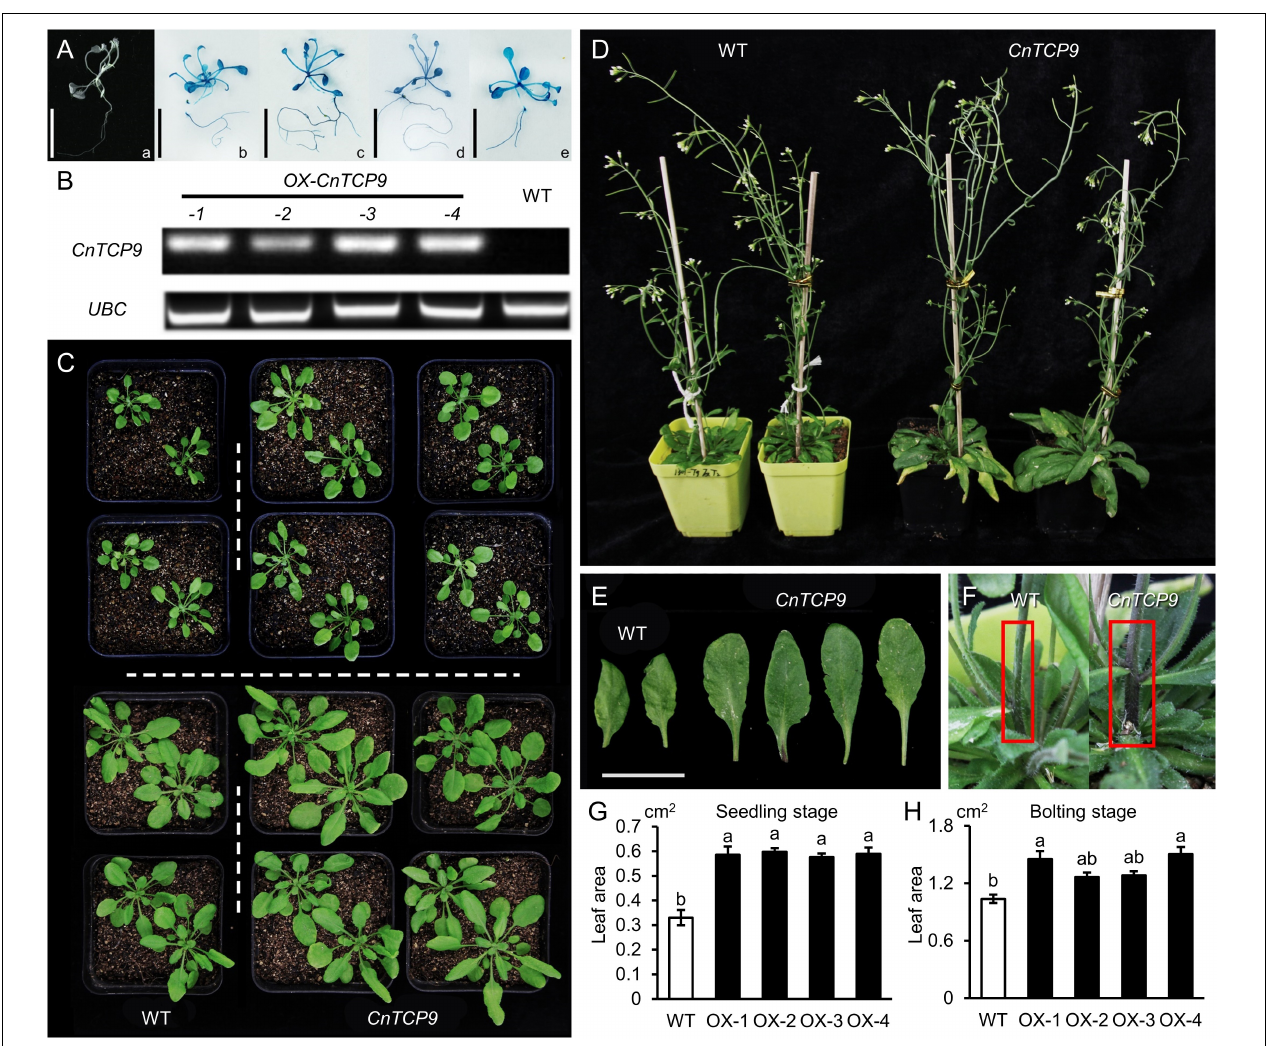
FIGURE 5 | Phenotype of overexpressing CnTCP9 in Arabidopsis. (A) GUS staining of T 3 generation. (a) Non-transgenic Arabidopsis was used as the negative control. (b–e) Transgenic CnTCP9 positive seedlings. (B) RT-PCR of CnTCP9 in WT and OE (Overexpressing CnTCP9 Arabidopsis). (C) Germination period and seedling period of WT and OE. (D) Mature period of WT and OE. (E) Leaves of WT and OE; bar = 2 cm. (F) The main stem of WT and OE. (G,H) Statistics of mature leaf area of WT and OE . Data are means ± SD . The different letters represent the values significantly different at p < 0.01 according to the one-way ANOVA